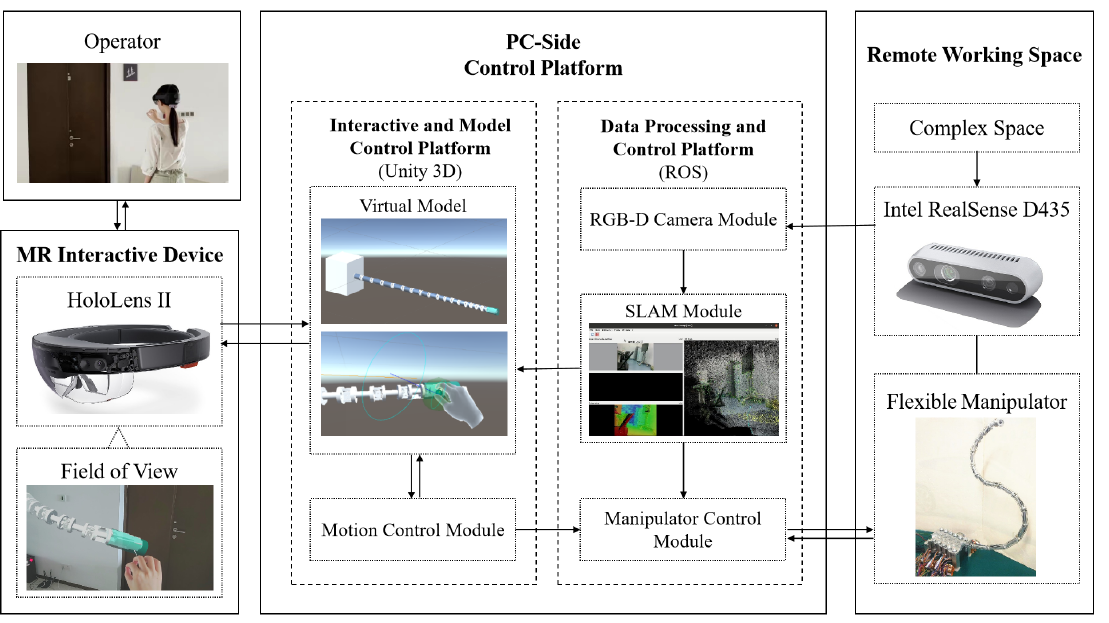
Figure 2. System